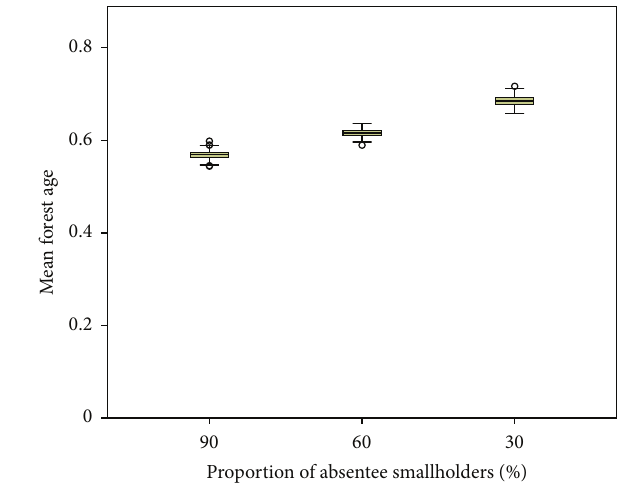
Figure 9: Average forest age (at the landscape scale) increases significantly with a decrease in absenteeism with high levels of social influenceandhighlevelsofsmallholdercharacteristicsthatarelikely to lead to clear